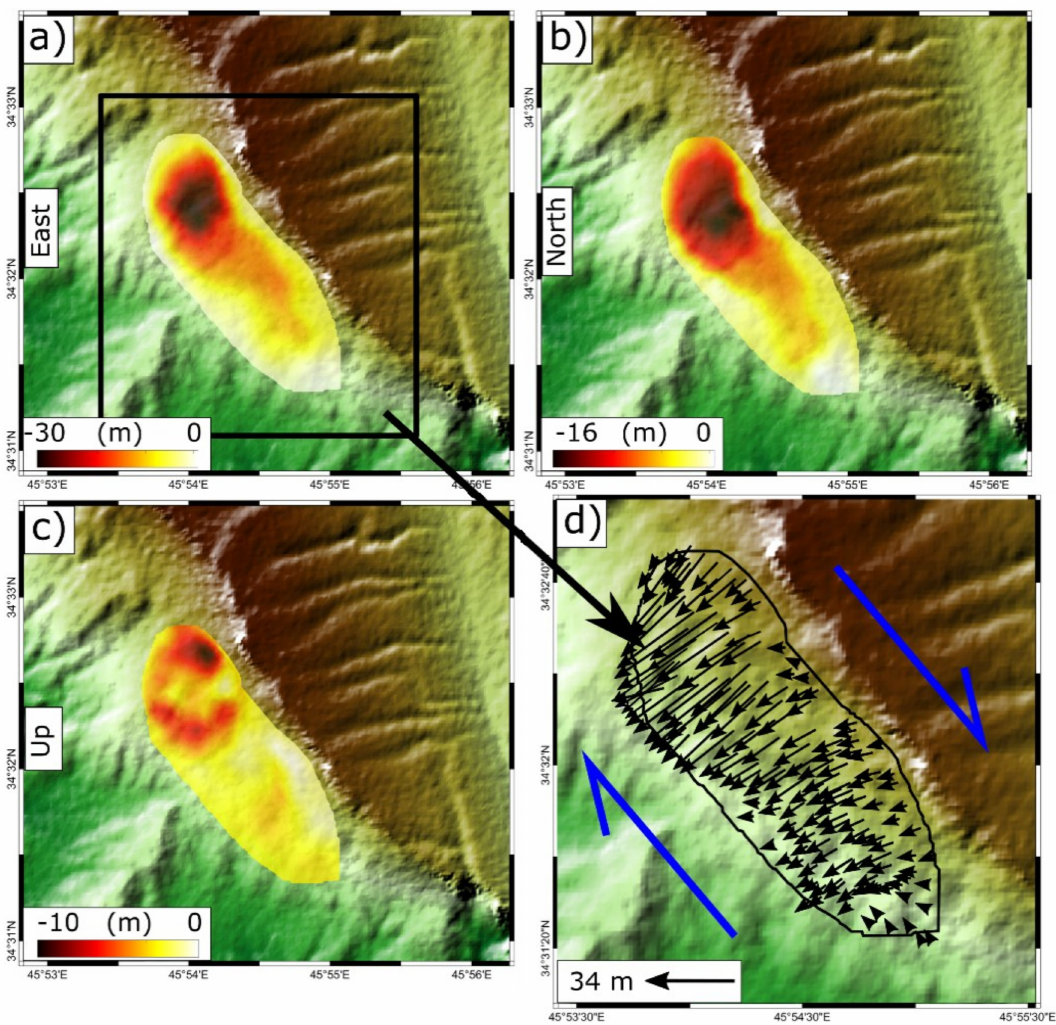
Figure 11. 3D decomposition of along-track and across-track observations to derive ( a ) east–west displacement, ( b ) north–south horizontal movement, and ( c ) up–down displacement. Along-track and across-track observations were generated based on the combined offset-tracking method. Due to decorrelation, SAR interferometry was not able to resolve deformation signal in this area (see Figure 3i). ( d ) Horizontal movement represented as a vector shape. Blue arrows correspond to strike-slip motion along the fault passing through the